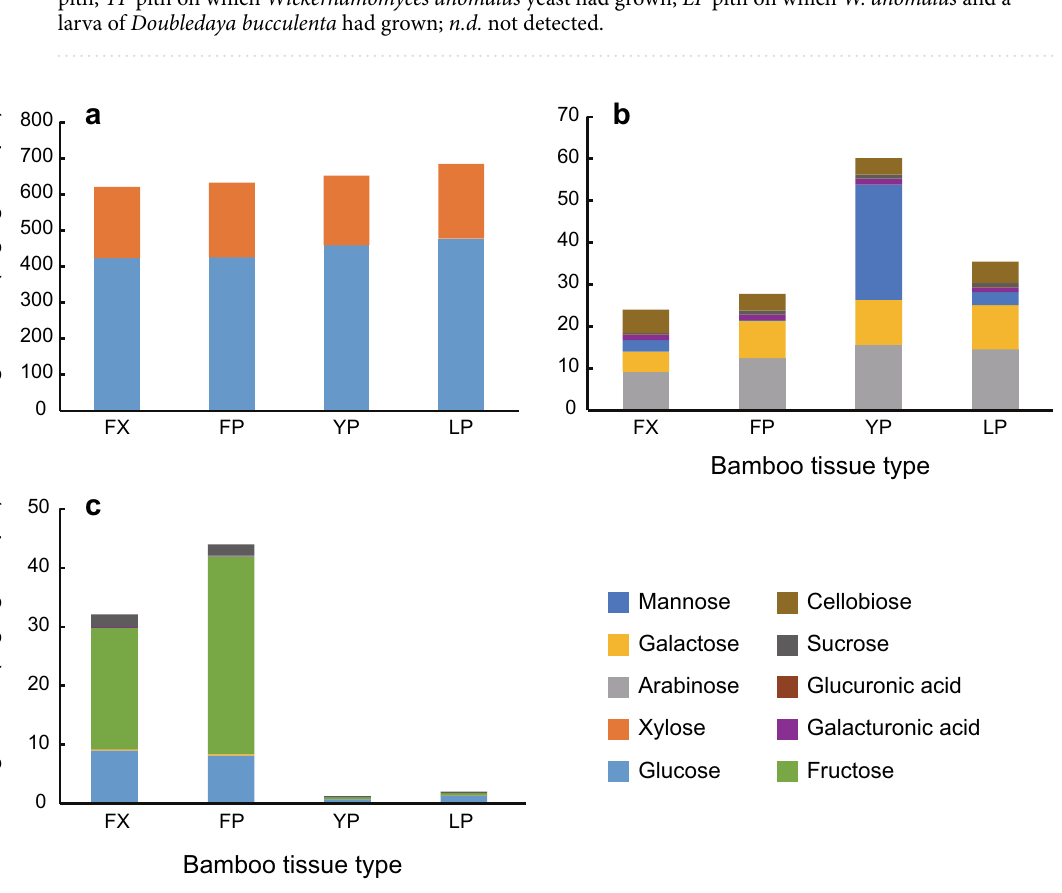
Figure 1. Weight ratios of structural and free sugars of Pleioblastus simonii bamboo internodes. ( a ) Major structural sugars (glucose and xylose). ( b ) Minor structural sugars (arabinose, galactose, mannose, galacturonic acid, glucuronic acid, sucrose, and cellobiose). ( c ) Free sugars (glucose, xylose, arabinose, galactose, mannose, fructose, galacturonic acid, and sucrose). Each column represents the mean of a given sugar of five internode samples. FX fresh xylem, FP fresh pith, YP pith on which Wickerhamomyces anomalus yeast had grown, LP pith on which W. anomalus and a larva of Doubledaya bucculenta had